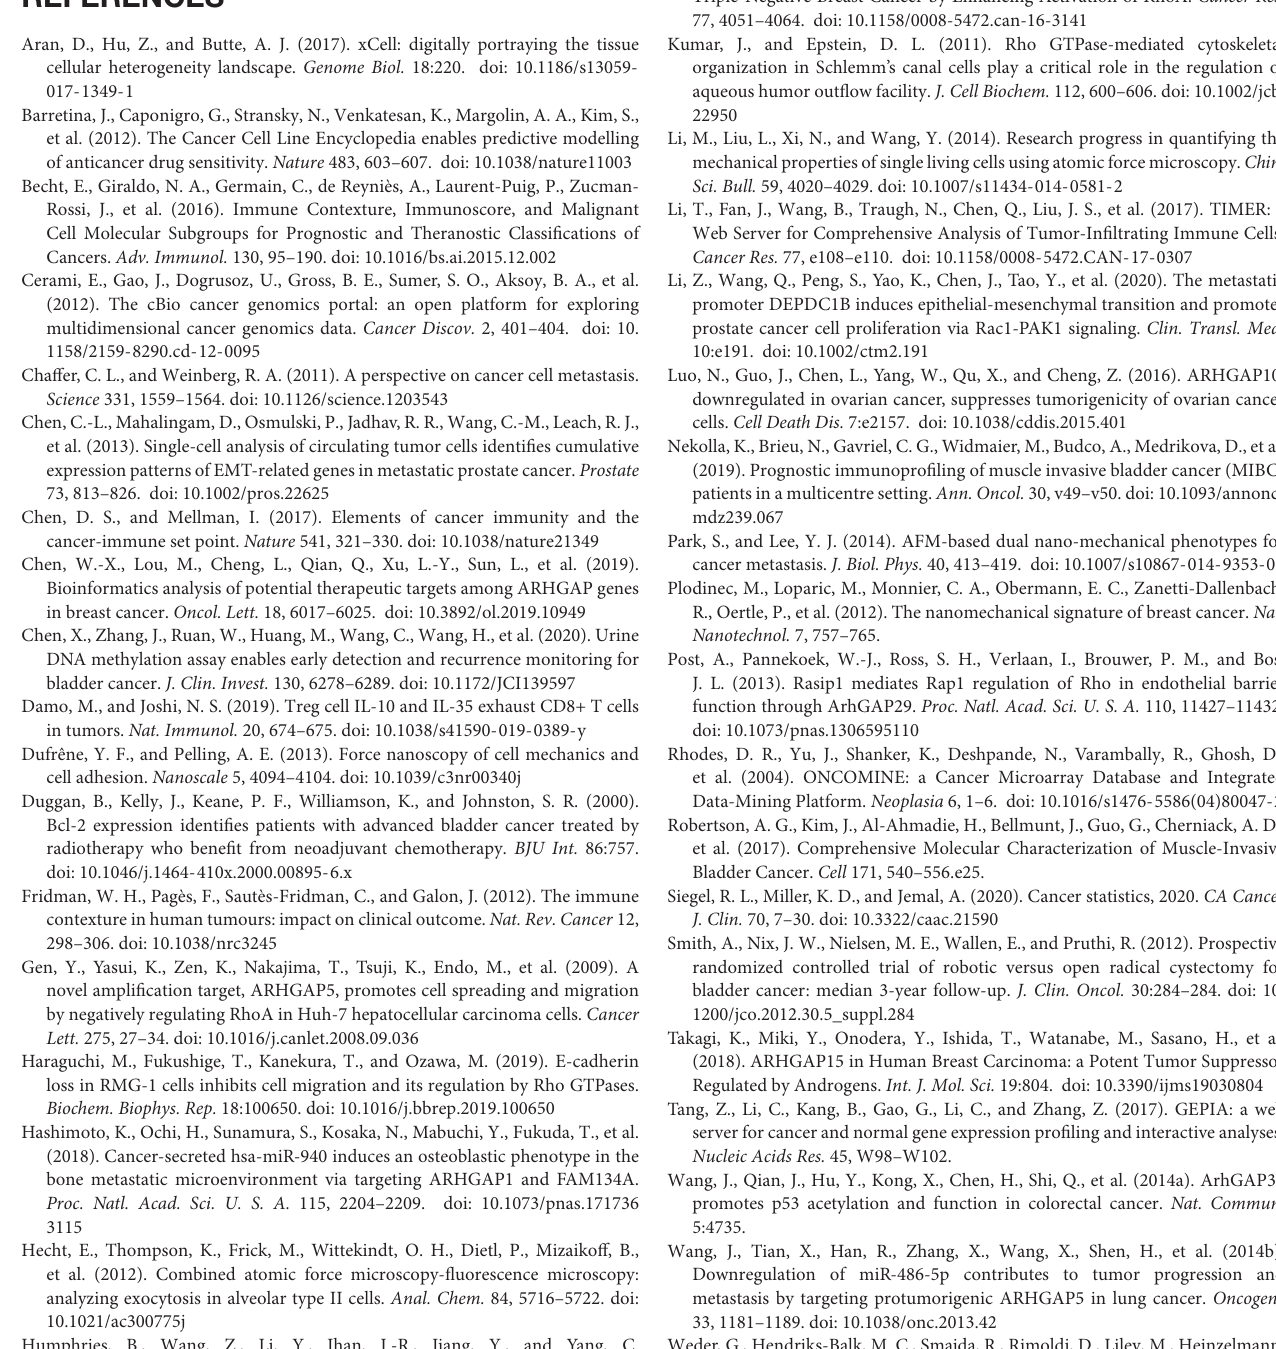
T helper (Th1) cells, type 2 T helper (Th2) cells, natural killer (NK) cells, Treg cells, M1 macrophages, M2 macrophages and Dendric cell were analyzed through xCell analyzed TCGA samples in BCa. Grouping was done according to the expression level of prognosis related ARHGAP family gene. ( ∗ p < 0.05; ∗∗ p < 0.01; ∗∗∗ p < 0.001; ns, not statistically significant, Wilcoxon signed rank test). Supplementary Figure 4 | Gating strategy for CD8+ T